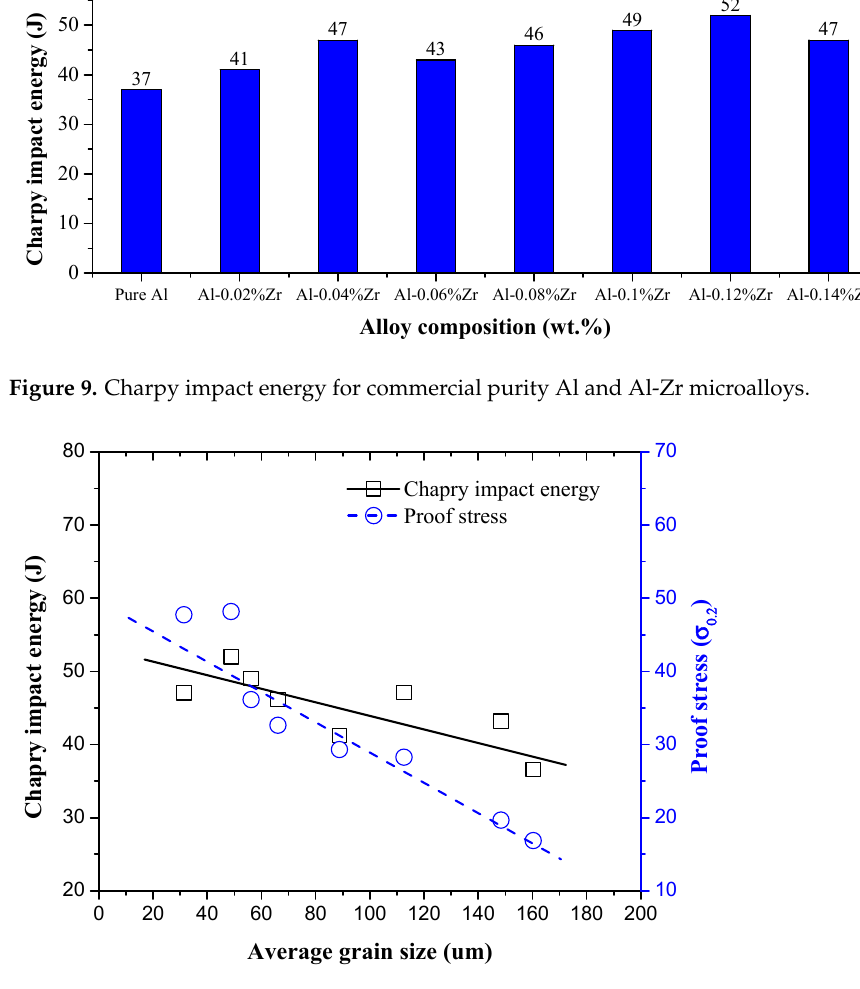
Figure 10. Charpy impact energy and proof stress for commercial purity Al and Al-Zr microalloys as functions of grain size.